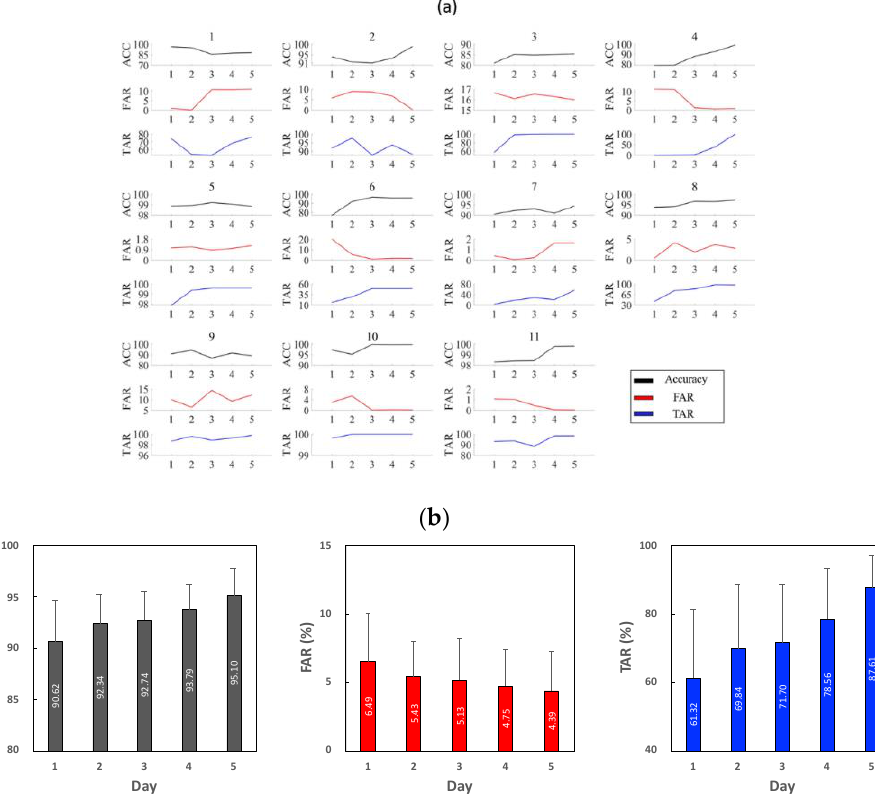
Figure 11. The accuracy, false acceptance rate (FAR) and true acceptance rate (TAR) of 11 subjects over five days of incremental learning ( a ) and the average ( b ) tested using the data of day 6. The experiment result over the five-day incremental learning as evaluated using the data recorded a day after the latest training is presented in Figure 12. Although there was a slight decrease of the performance when the evaluation was conducted using the data